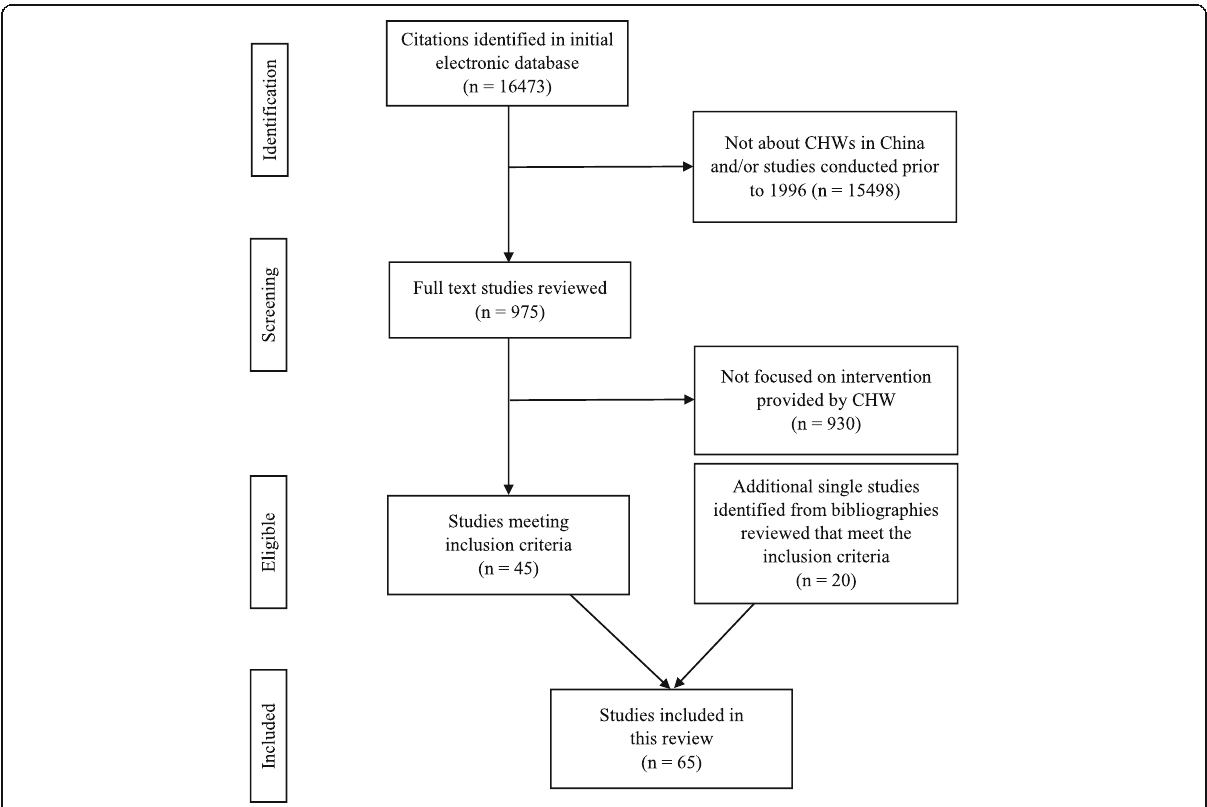
Fig. 2 Selection Process for Identifying Relevant